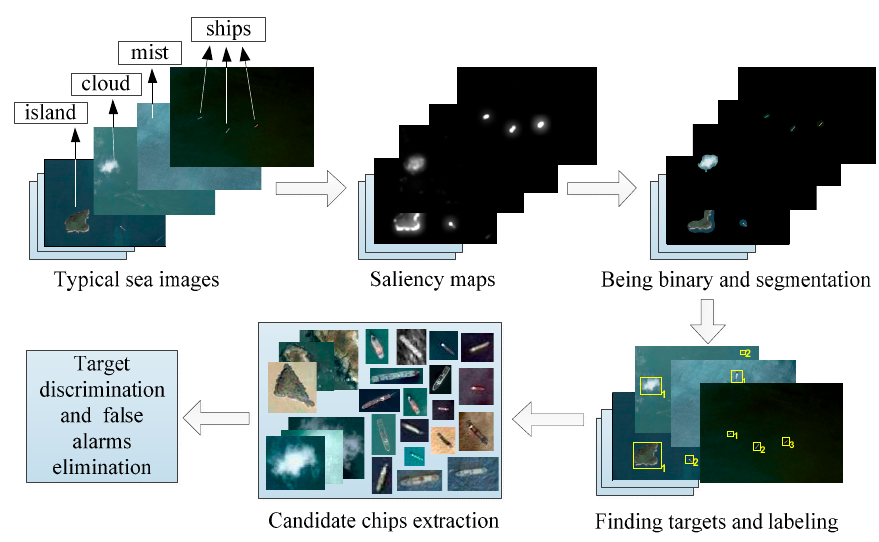
Figure 2. Saliency estimation of ship target in the first stage.